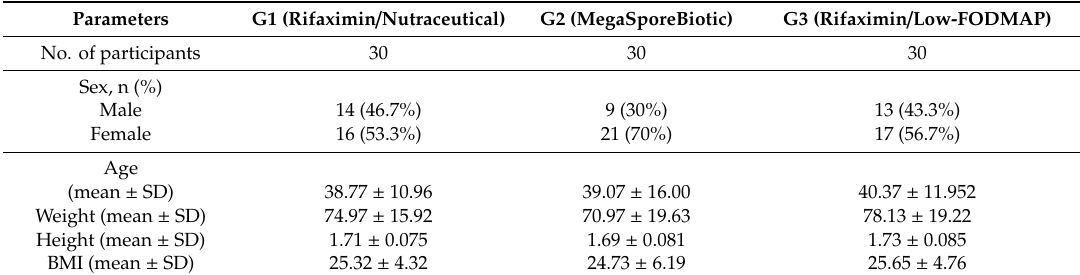
Table 1. Patient demographics at baseline.